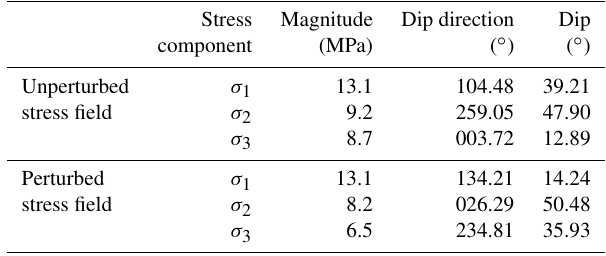
Table 2. Stress field information for the perturbed and unperturbed stress states (Krietsch et al., 2019). The perturbed stress tensor was measured at a distance of 5m from the S3 shear